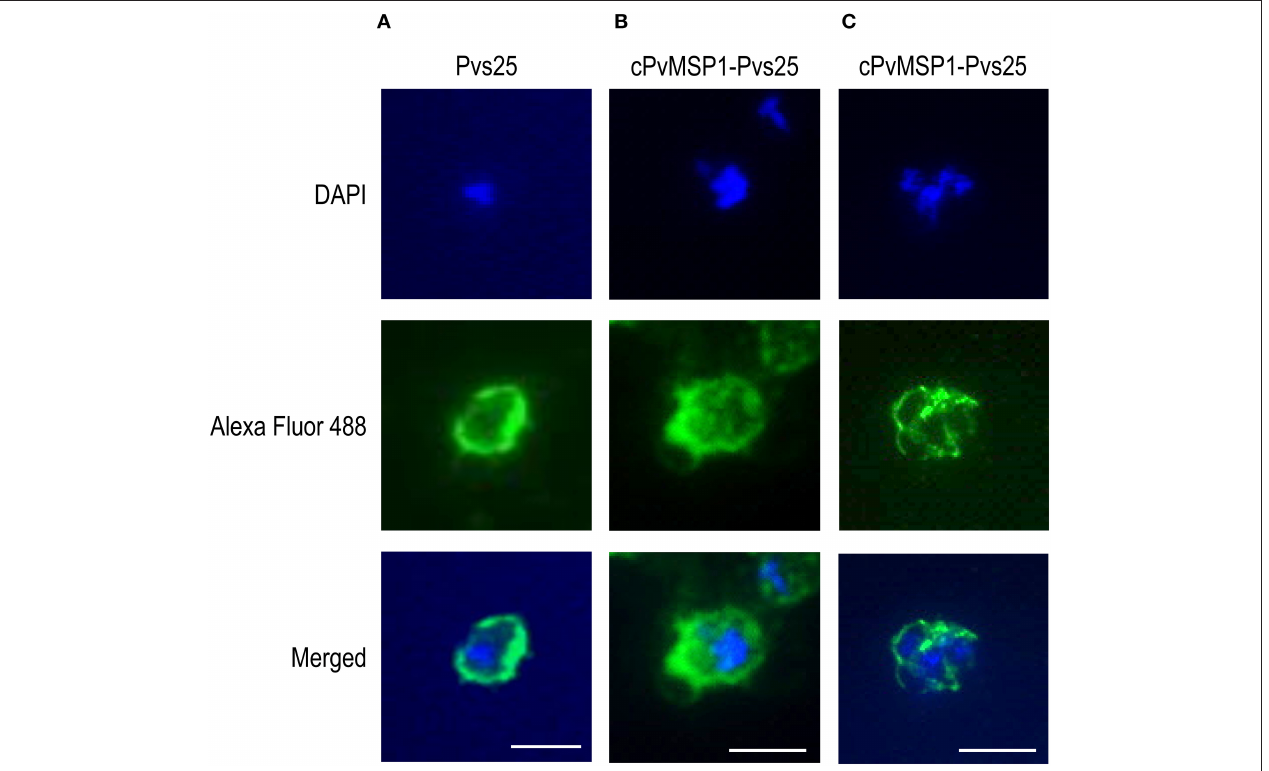
FIGURE 4 | Immunofluorescence assays of young oocysts and schizonts. Sera from individual rabbits immunized with either Pvs25 or cPvMSP1-Pvs25 was used to assess reactivity against in vitro derived oocysts using the P. berghei transgenic parasite expressing Pvs25 (A, B) . A pool of sera obtained from CB6F1/J mice 20 days after the final immunization with cPvMSP1-Pvs25 was used to assess reactivity against blood-stage P. vivax parasites (C) . The upper panels show staining with DAPI, the middle panels show staining with either goat-anti-rabbit or goat-anti-mouse IgG (H + L) Alexa Fluor 488 secondary antibody, and the bottom panels show the merged images. All images are shown at 100x magnification: scale bars, 5 µ